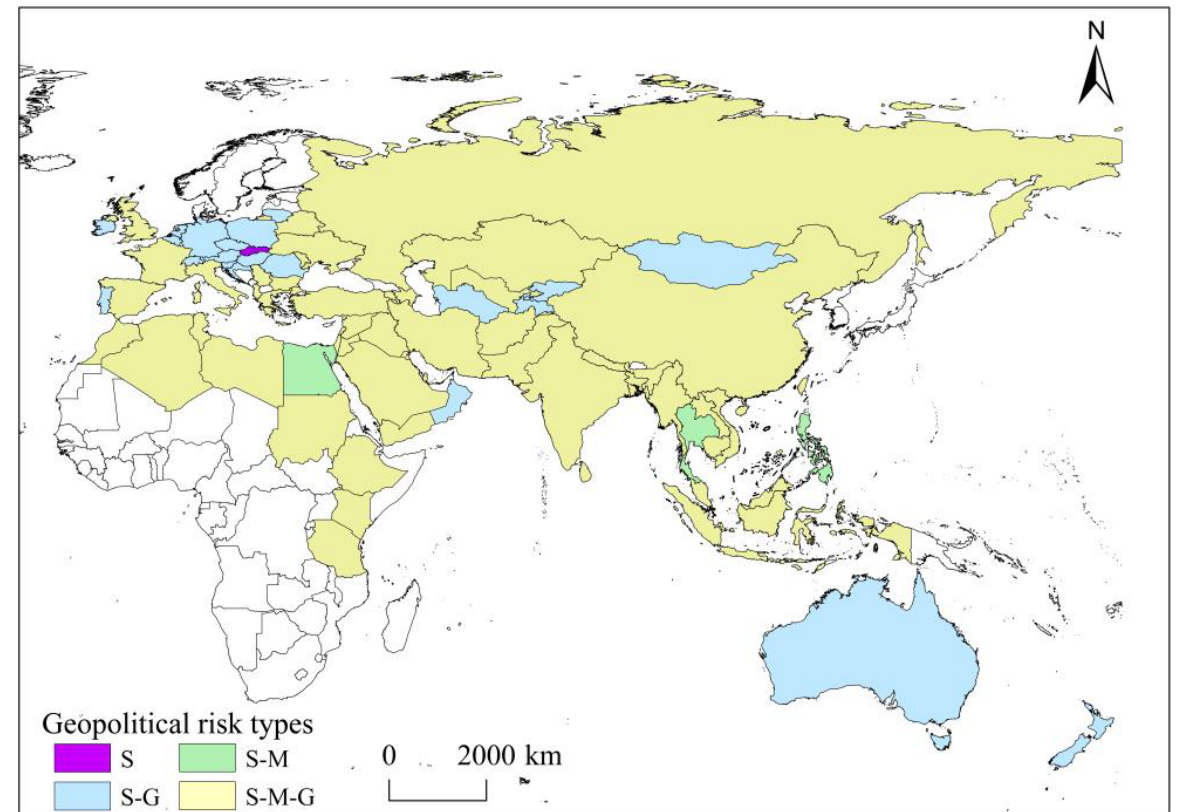
Figure 5. Geopolitical risk types of countries along the Belt and Road. Note: The map is drawn to the standard map of GS (2016) 1667 that come from the standard map service system of the ministry of natural resources of the people’s Republic of China (http://bzdt.ch.mnr.gov.cn/index.html, accessed on 8 December 2022).